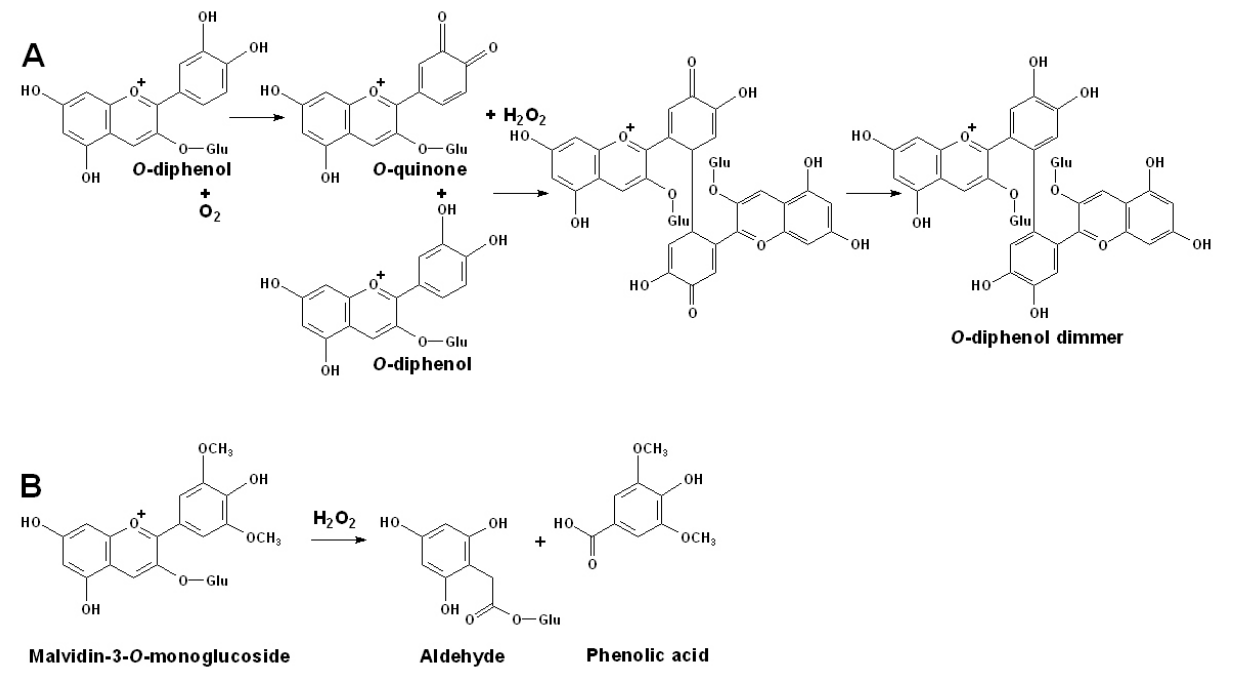
Figure 6. (A) Autoxidation of o -diphenols to produce o -diquinones and the following o - diphenols dimer. (B) Degradation of anthocyanin by the oxidation of hydrogen peroxide